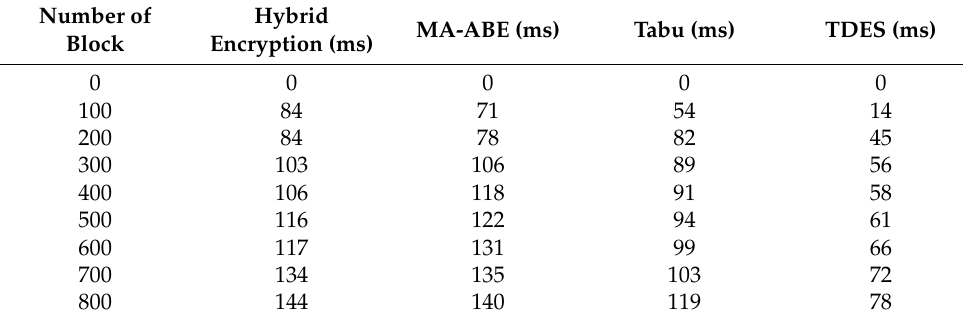
Table 10. Latency of TDES and comparison with existing technique.